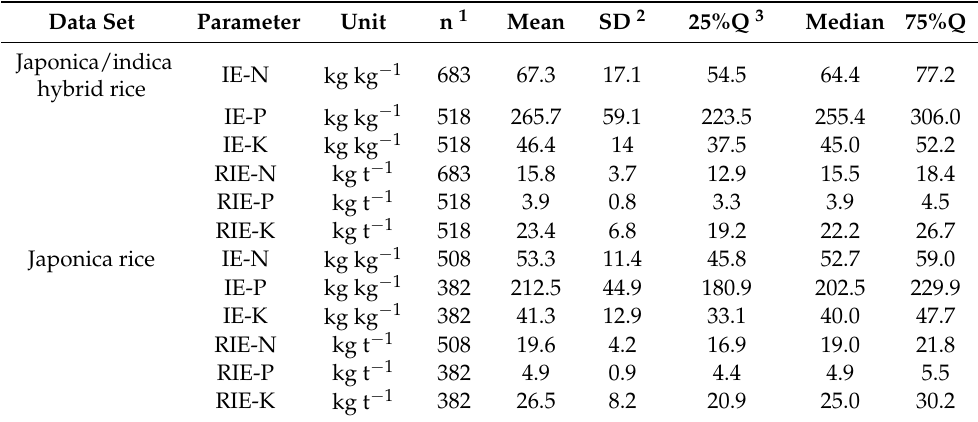
Table 2. Internal efficiency (IE) and reciprocal internal efficiency (RIE) of N, P, and K for japon- ica/indica hybrid rice and japonica